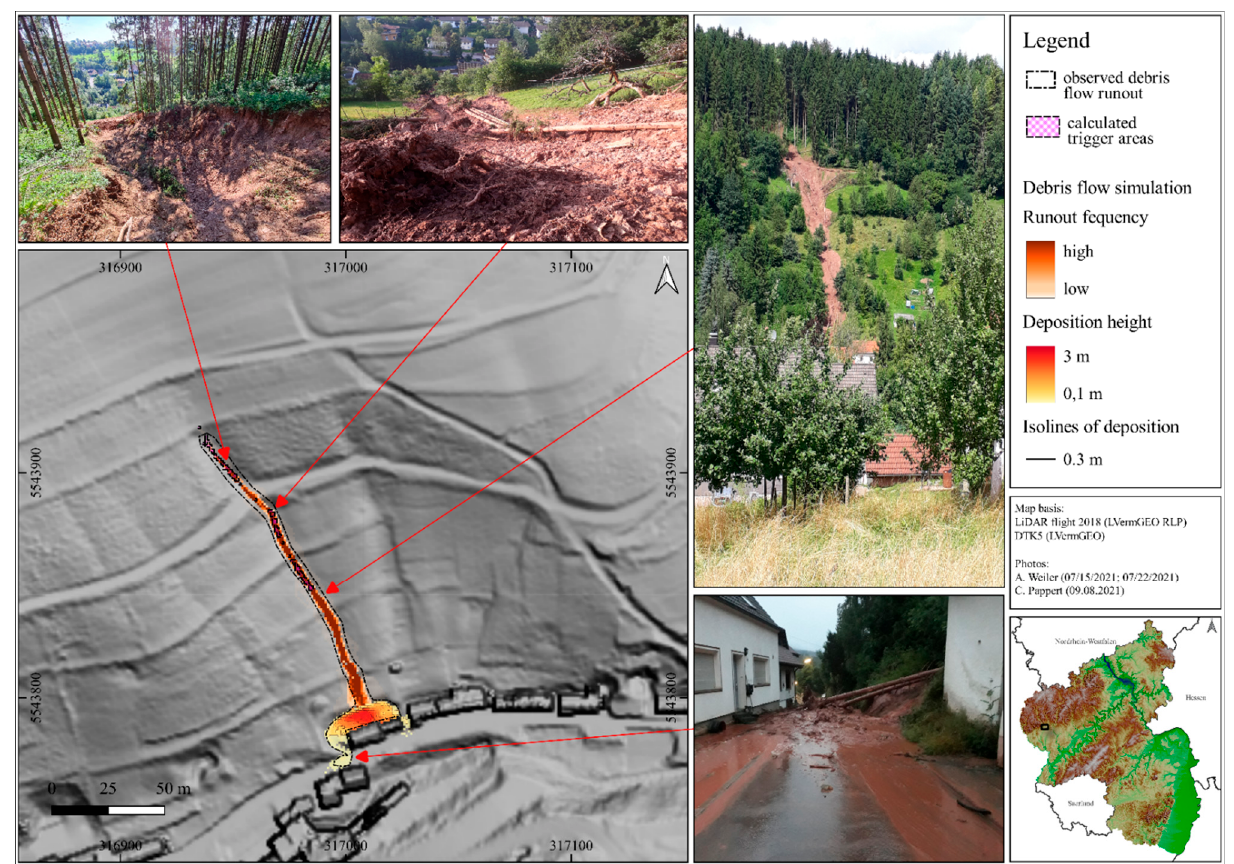
Figure 8. Modeled runout and deposition behavior of the debris flow with calculated trigger areas and photographic comparison to the in situ